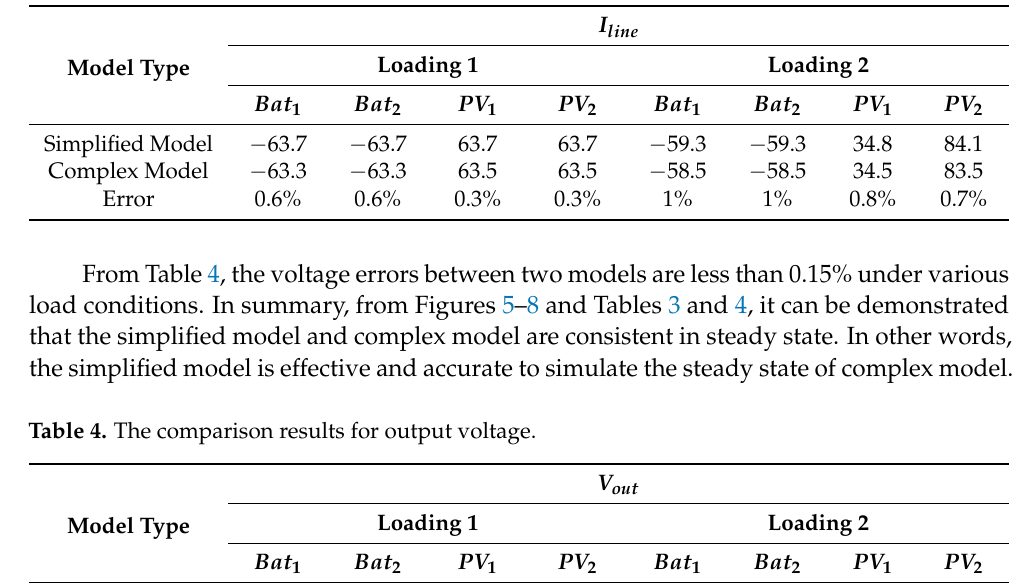
Table 3. The comparison results for line current.